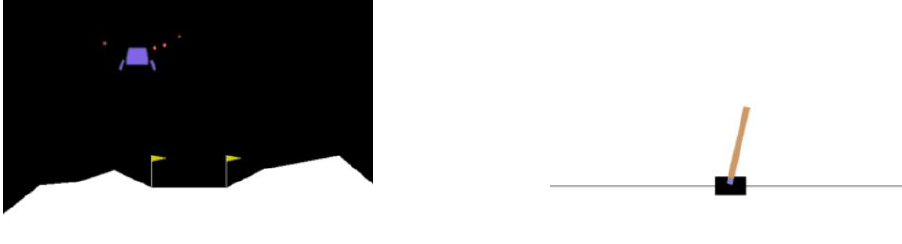
Figure 2. From left to right: LunarLander-v2,